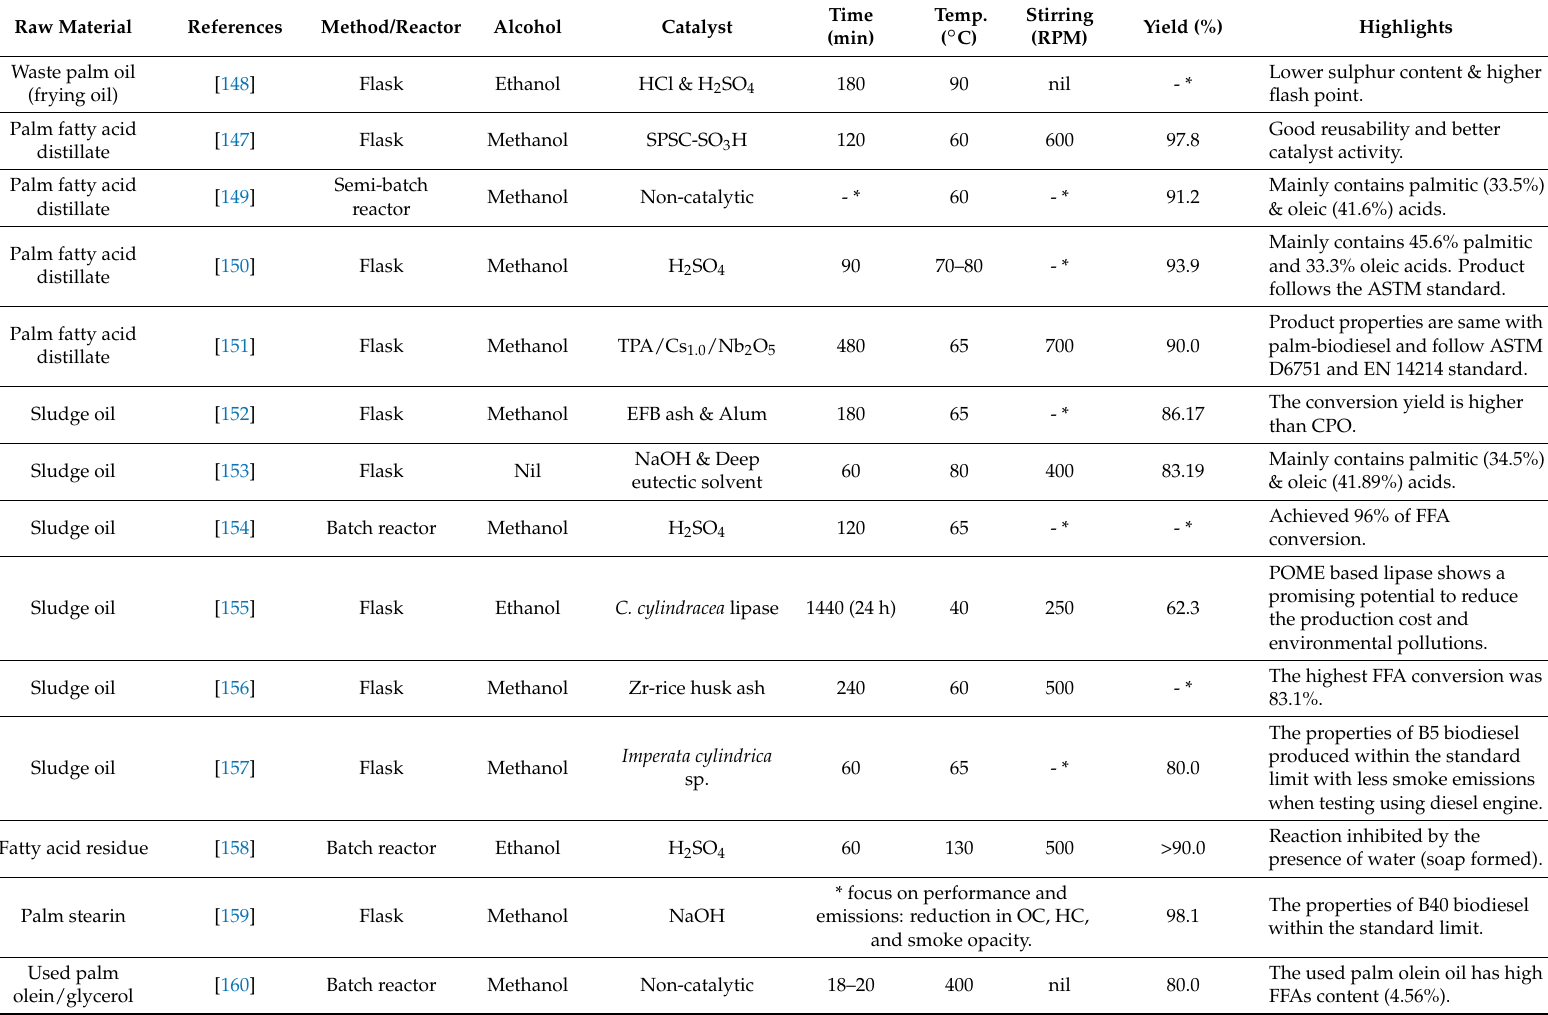
Table 11. Production of biodiesel from palm oil by-products and mill